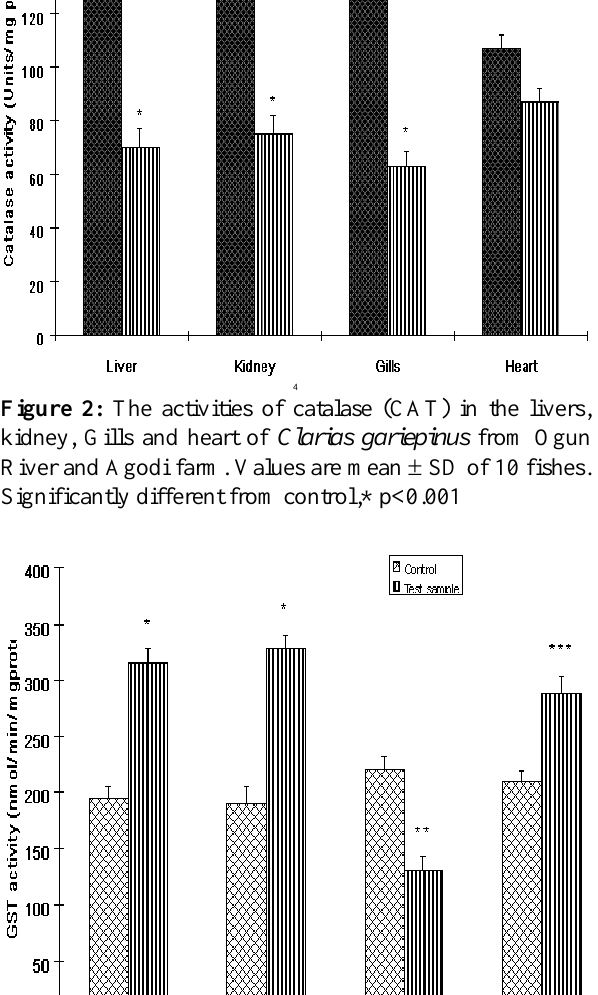
Glutathione Level